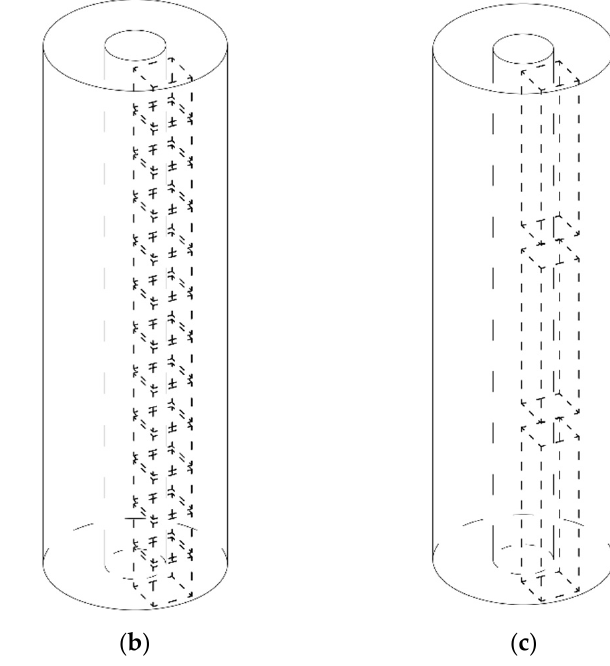
Figure 2. Scheme of sawing out samples from elements of an annular section, made by centrifuga- tion and vibrocentrifugation: ( a ) top view; ( b ) sample cubes; ( c ) prism samples.